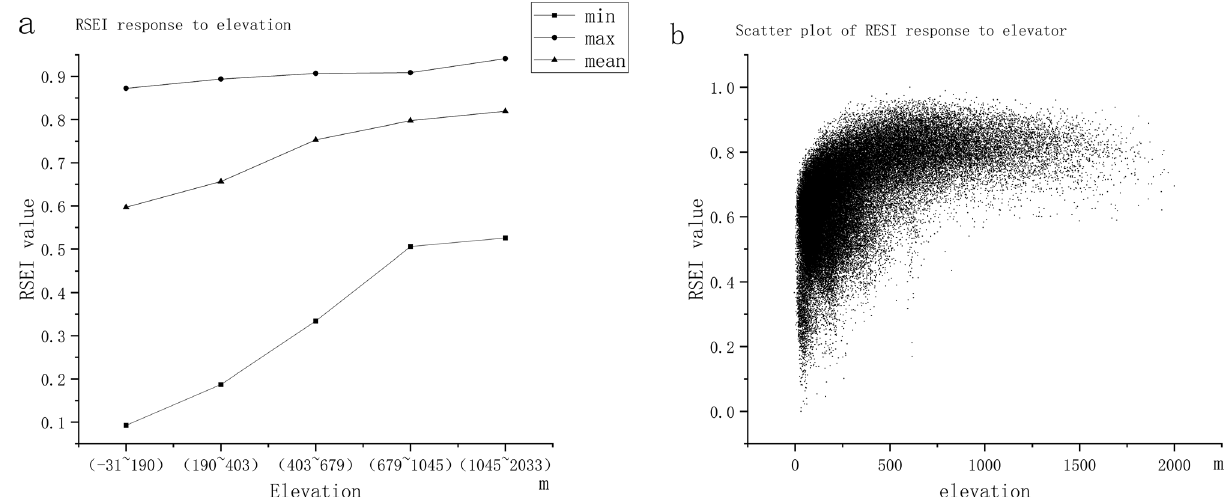
Figure 6. ( a ) RSEI values for different altitude ranges, ( b ) scatter plot of the relationship between RSEI and